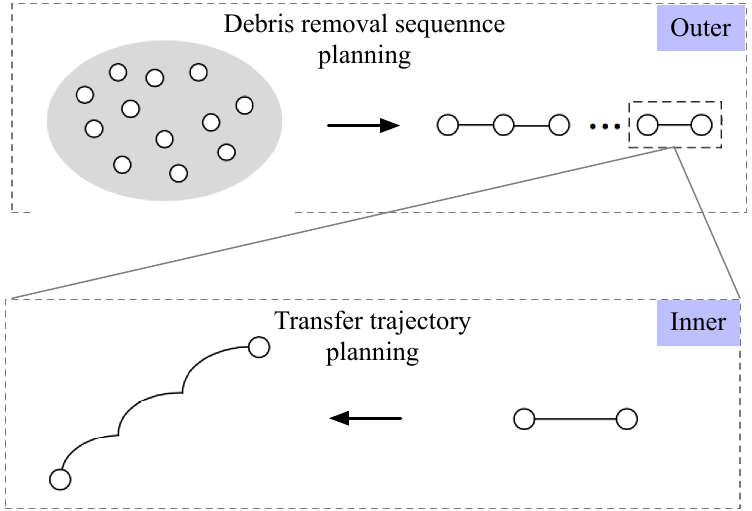
Figure 1. Decomposition of the active space debris removal mission planning